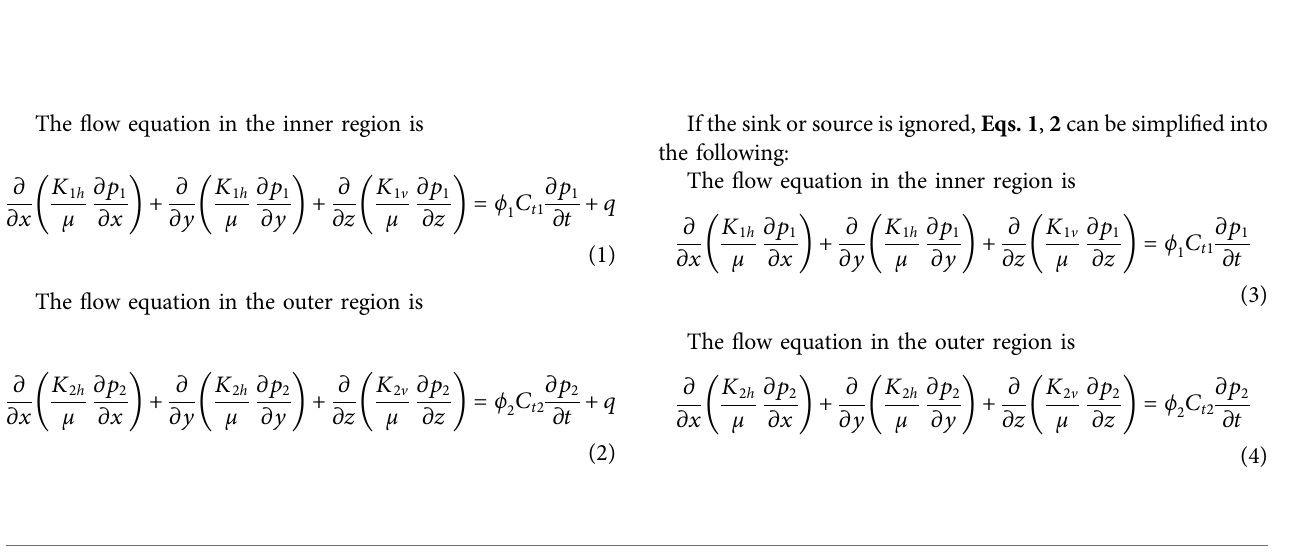
Frontiers in Energy Research |